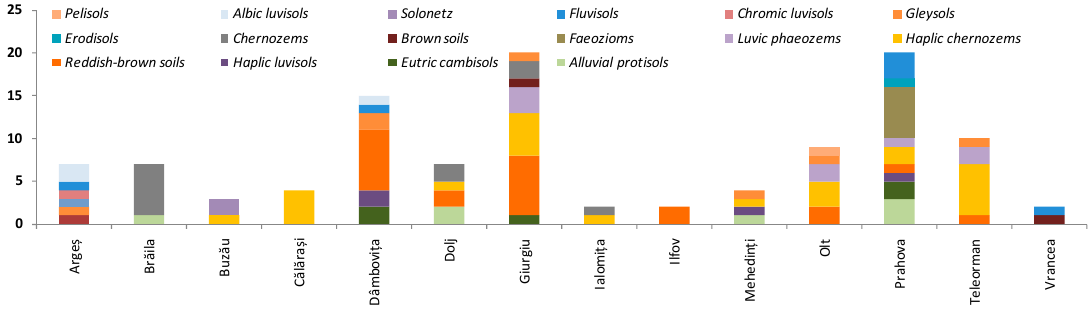
Figure 10. PV farm distribution in relation to main soil types and counties.